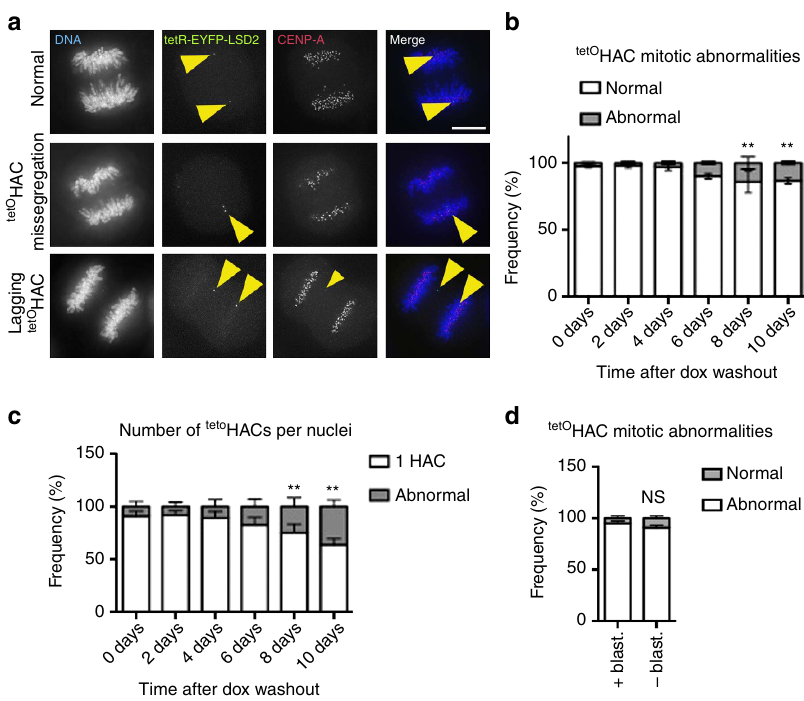
Figure 4 | LSD2 activity at the alphoid tetO HAC centromere affects kinetochore function and leads to chromosome segregation defects. ( a ) Representative immunofluorescence images of mitotic 1C7 cells expressing the tetR-EYFP-LSD2 WT fusion protein and stained for CENP-A. Images show examples of normal (top) and abnormal alphoid tetO HAC segregation (middle and bottom rows). Arrowheads depict the HAC. Scale bar, 10 m m. ( b ) Analysis of the frequency of normal and abnormal alphoid tetO HAC segregation at the indicated time points. Data represent the mean (and s.e.m.) of three independent assays of each time point after doxycycline washout ( n ¼ 25 mitosis per time point and experiment; 0 days versus each time point, ** P o 0.0001; w 2 -test). ( c ) Quantification of alphoid tetO HAC copy-numbers as determined by the EYFP spot in interphase nuclei. Data represent the mean (and s.e.m.) of three independent assays of each time point after doxycycline washout ( n ¼ 1,000 nuclei per time point and experiment; 0 days versus each time point, ** P o 0.0001; w 2 -test). ( d ) Analysis of the frequency of normal and abnormal alphoid tetO HAC segregation in the presence and absence of selection (Blasticidin) for 10 days. The alphoid tetO HAC was identified by in situ tetR-EYFP tethering (see Supplementary Fig. 2). Data represent the mean (and s.e.m.) of three independent